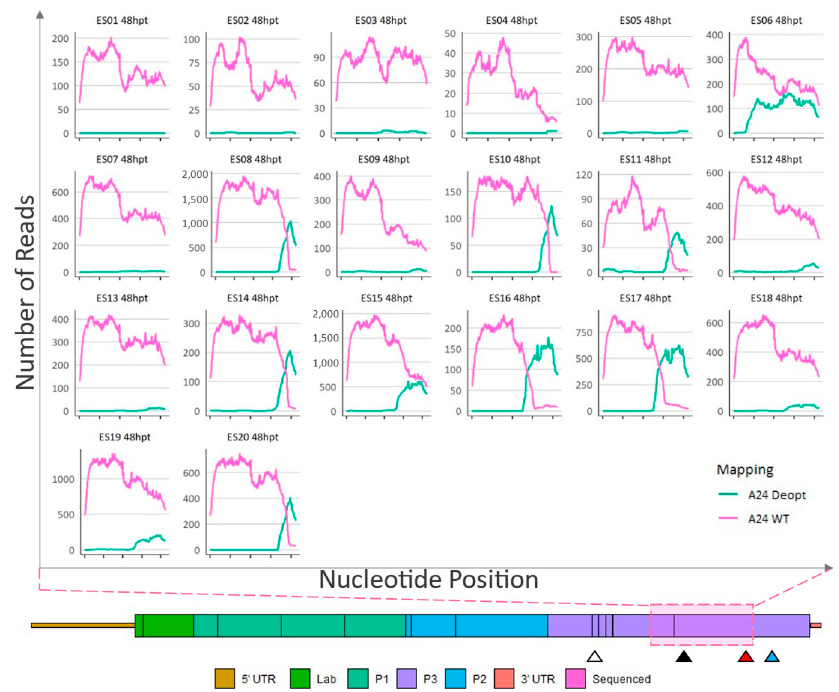
Figure 6. Sequence analysis of 48-hpt Δ P1-P2P3Deopt × Δ GDD recombinant plaque isolates. Locations ( x -axis) and counts ( y -axis) of reads that preferentially map to either a A24-WT or A24-P2P3Deopt reference within a 1059 nt section of the 3CD coding region as indicated by the pink shaded box. Triangles indicate the location of the 3B DIVA marker (white), 3D DIVA marker (black), the boundary between deoptimized and non-deoptimized regions (red), and the GDD deletion (blue).